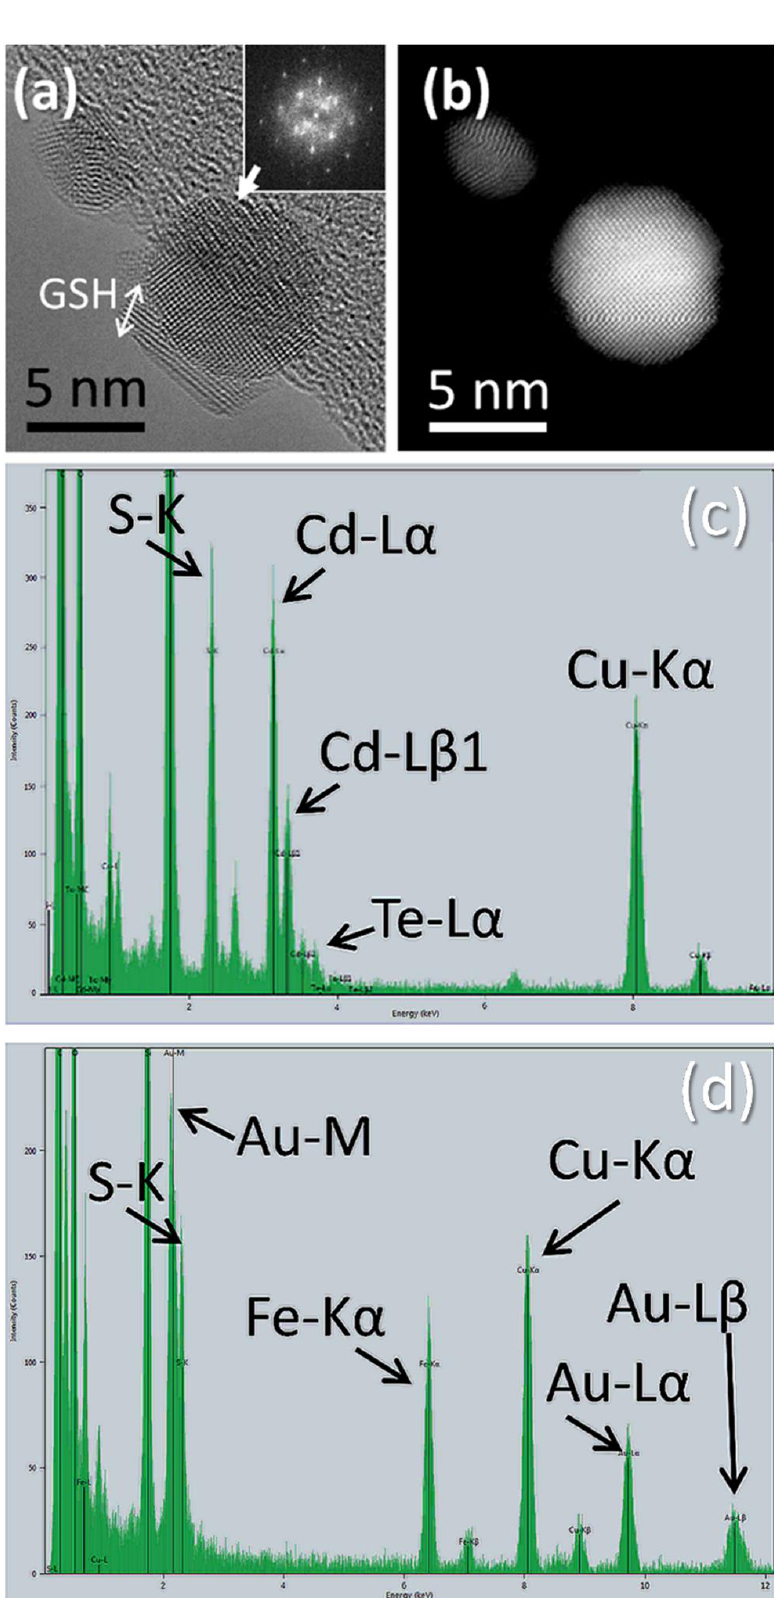
Figure 6. High-resolution TEM (HRTEM) ( a ) and HR-HAADF ( b ) images of NPs in sample Au-GSH. Punctual energy-dispersive X-ray (EDX) spectrum from QD-GSH ( c ) and from Au-Mag-GSH ( d ) NPs.